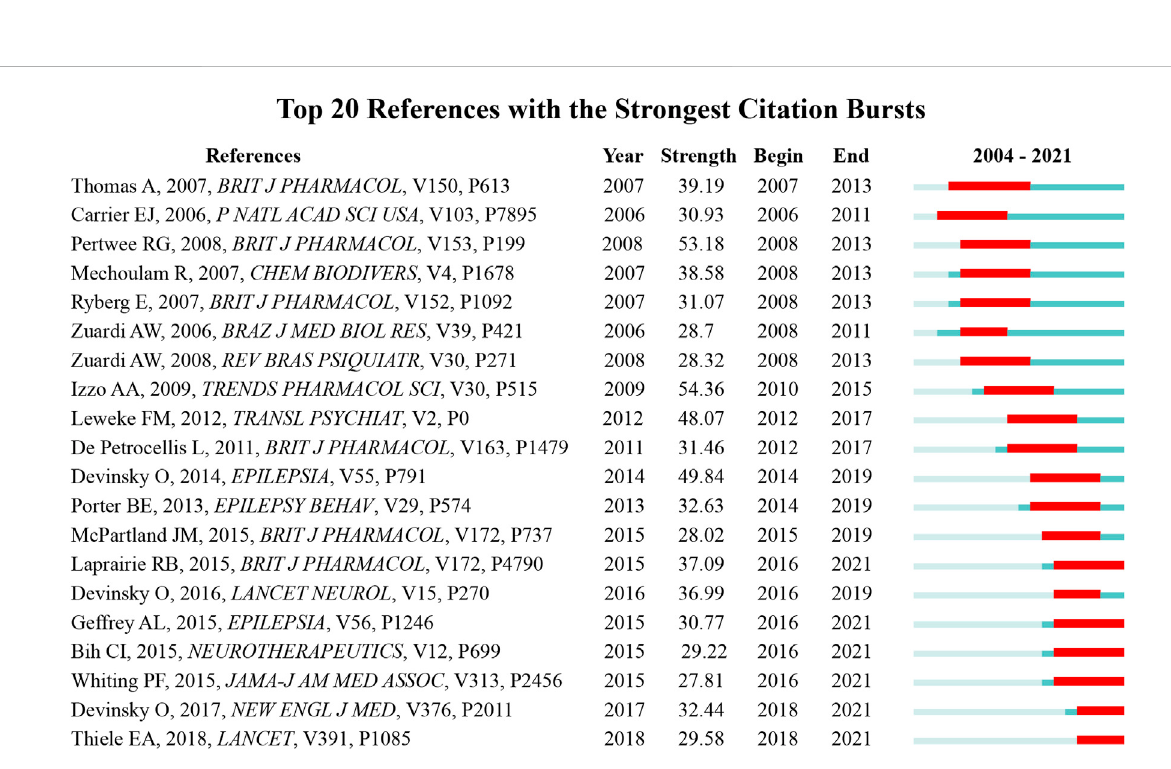
FIGURE 7 The top 20 references with the strongest citation